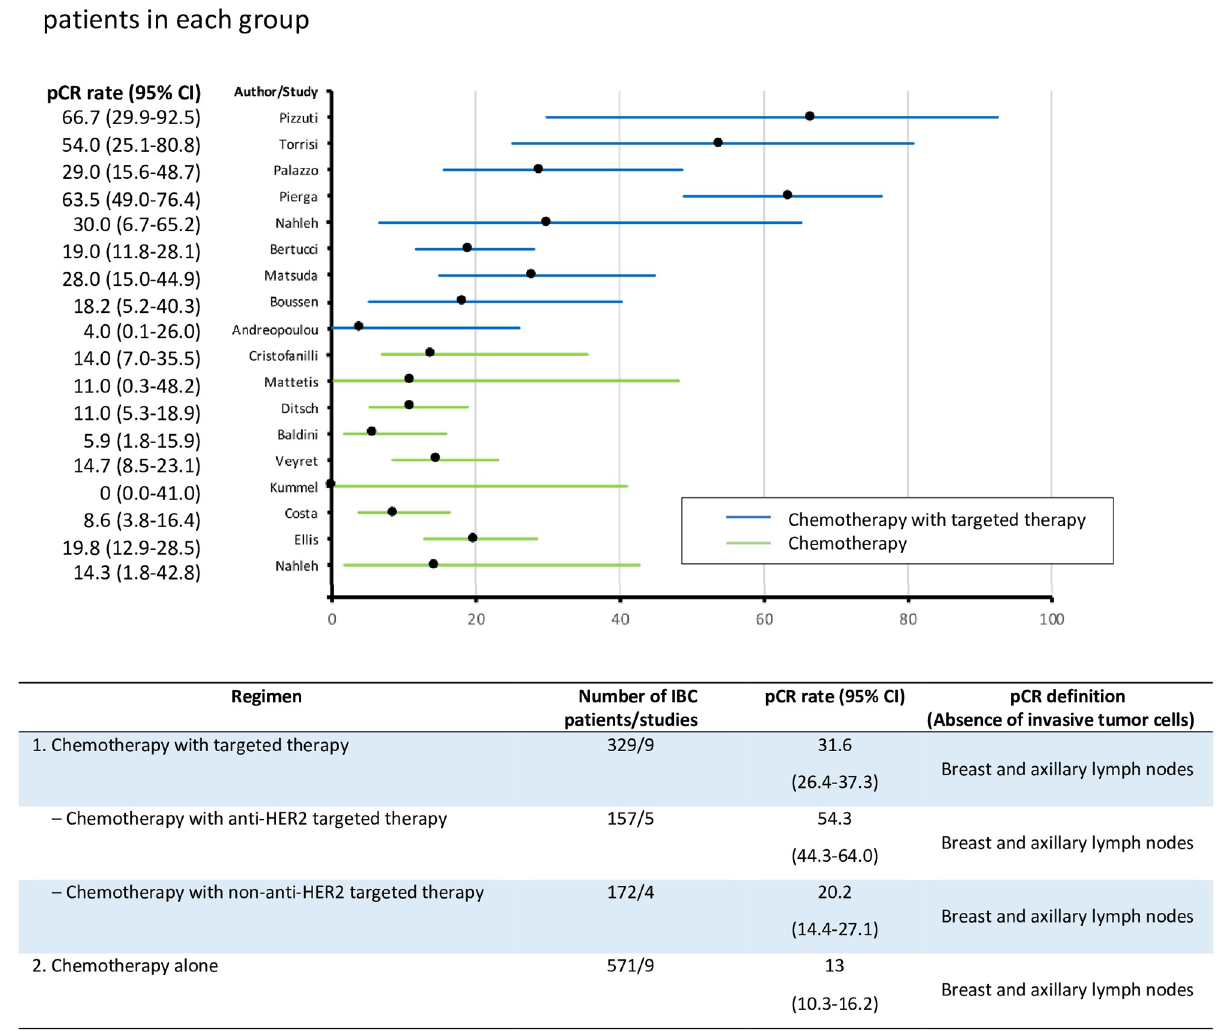
Fig 2. pCR rates for IBC patients in each study and weighted-average pCR rates for IBC patients in each group.